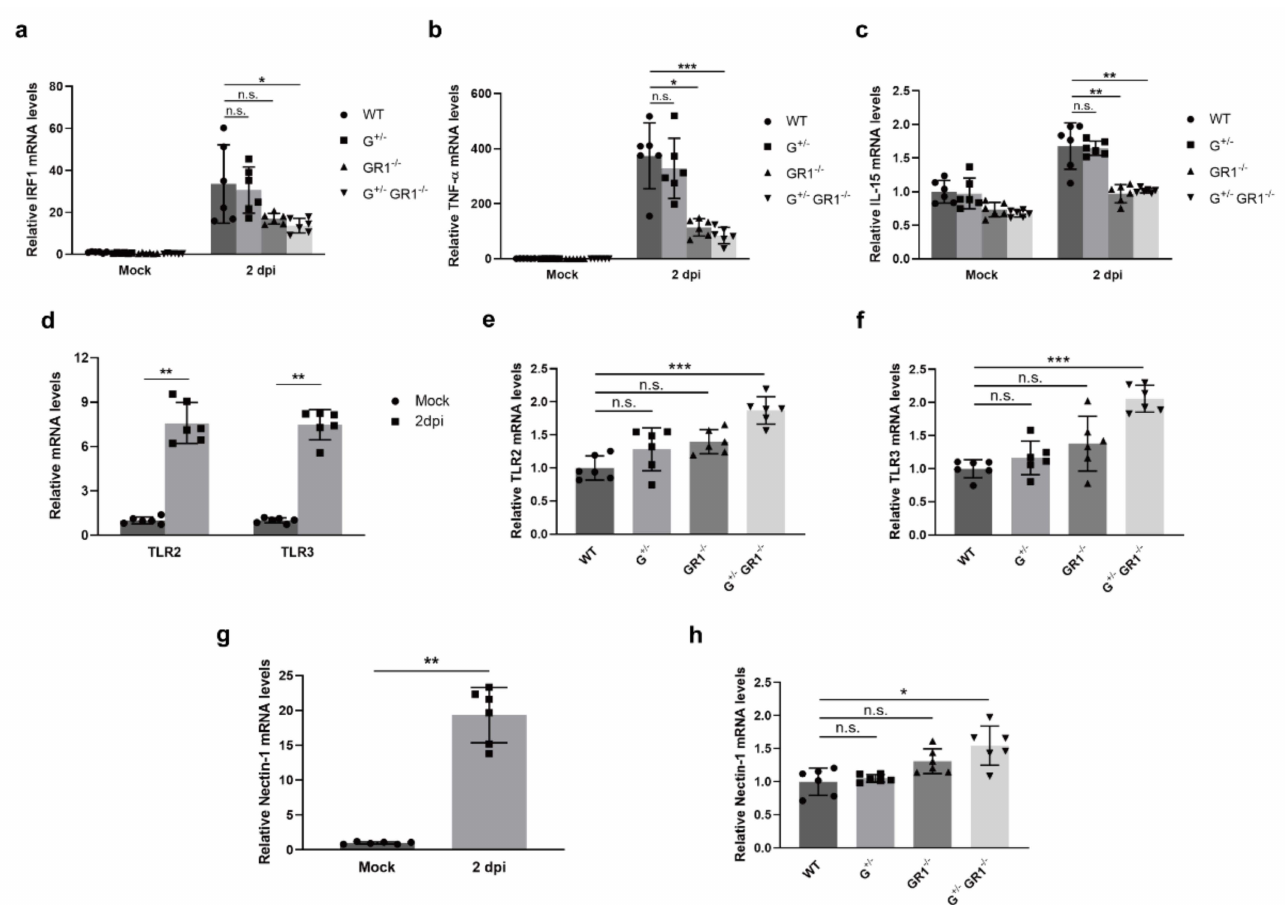
Figure 4. HSV-1 infection causes downregulation of IFN- γ -induced cytokines coupled with an increase in the receptor responsible for HSV-1 entry in IFNG - and IFNGR1 -knockout Vero cell lines. ( a – c ) Relative IRF-1 ( a ), TNF- α ( b ), and IL-15 ( c ) expression levels in G +/ − , GR1 − / − , and G +/ − GR1 − / − cell lines after HSV-1 infection. IRF-1, TNF- α , and IL-15 mRNA levels in knockout cell lines were normalized to those of uninfected wild-type controls. Results are shown as means ± SD of six independent replicates (applies to all gene-expression data, * p < 0.05; ** p < 0.01; *** p < 0.001; n.s., not significant). ( d ) Relative expression levels of TLR2 and TLR3 in wild-type Vero cells 2 days after HSV-1 infection. TLR2 and TLR3 mRNA levels were normalized to those of uninfected controls. ( e , f ) Relative expression levels of TLR2 ( e ) and TLR3 ( f ) in G +/ − , GR1 − / − , and G +/ − GR1 − / − cell lines after HSV-1 infection. TLR2 and TLR3 mRNA levels in HSV-1 infected G +/ − , GR1 − / − , and G +/ − GR1 − / − cell lines were normalized to those of infected wild-type cells. ( g ) Relative expression level of the viral-entry-associated receptor, nectin-1, in wild-type Vero cells 2 days after HSV-1 infection. Nectin-1 mRNA level was normalized to that of uninfected controls. ( h ) Relative expression levels of nectin-1 in G +/ − , GR1 − / − , and G +/ − GR1 − / − cell lines after HSV-1 infection. Nectin-1 mRNA levels in HSV-1-infected G +/ − , GR1 − / − , and G +/ − GR1 − / − cell lines were normalized to those of infected wild-type